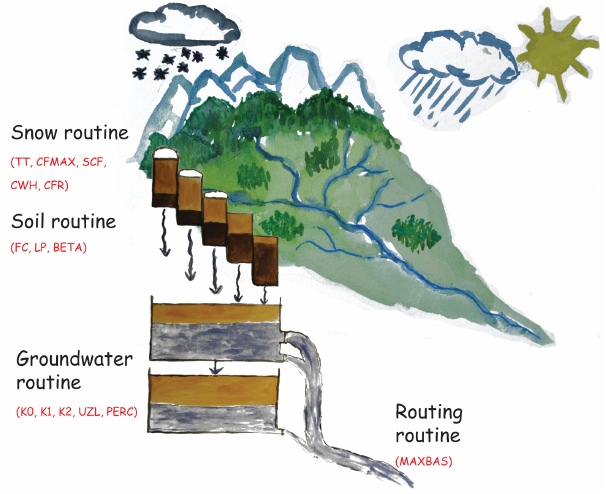
Fig. 1. Schematic structure of the HBV model.